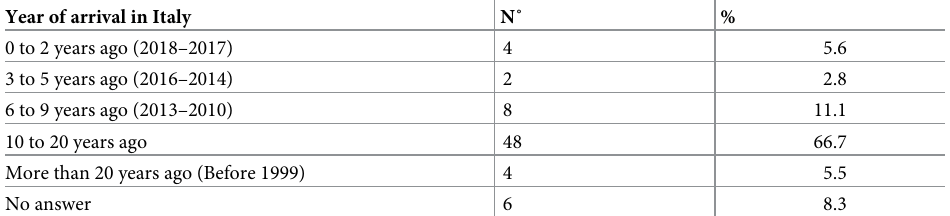
Table 3. Distribution of patients included in anthropological study on Chagas Disease 2016–2018 on the basis of their permanence in